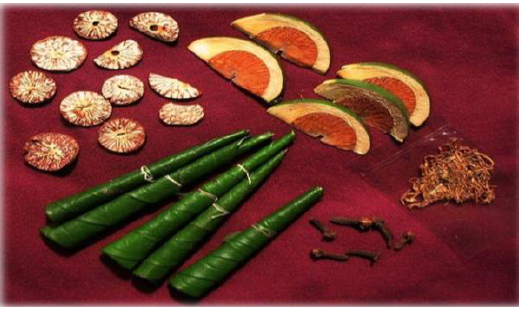
Figure 15. Materials used in preparing paan